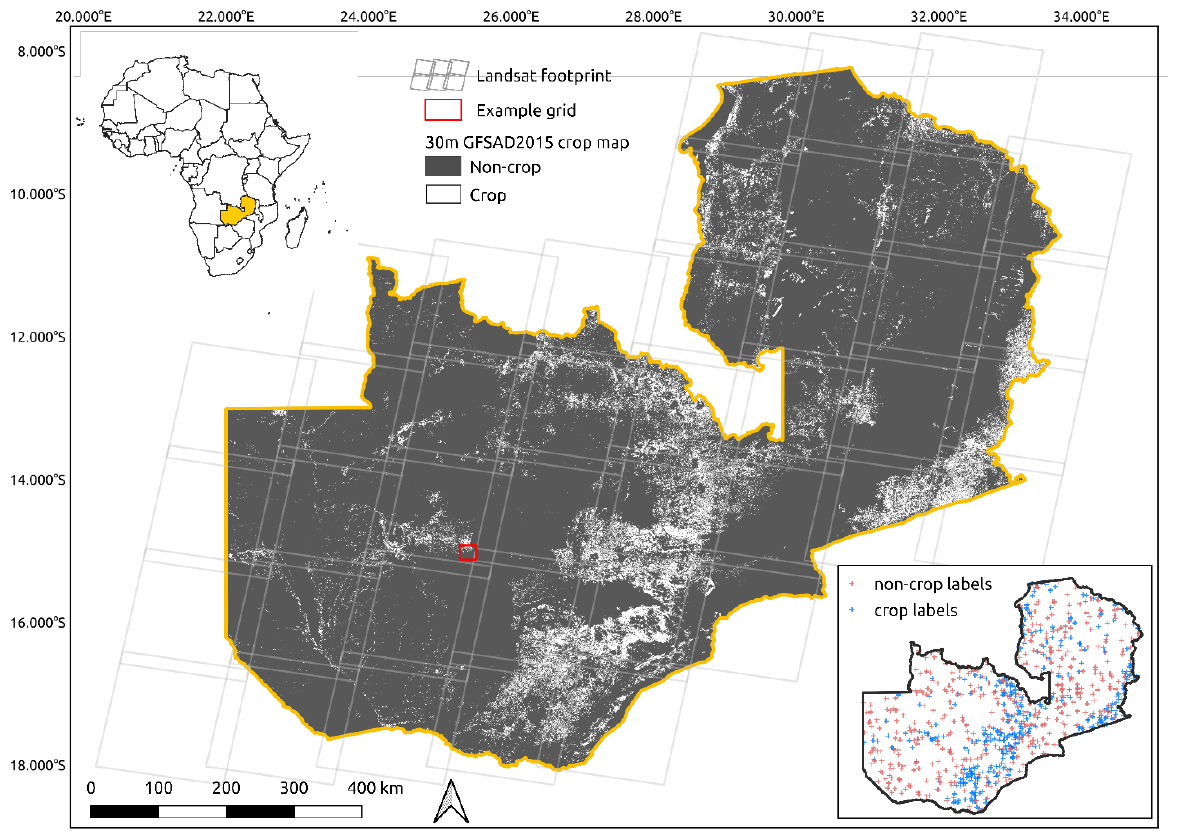
Figure 1. Study area figure showing Zambia study region, cropland coverage, and Landsat tile footprint. The 812 validation samples are shown in the lower right inset map, with cropland labels for 2015 shown in blue and non-cropland labels in red.